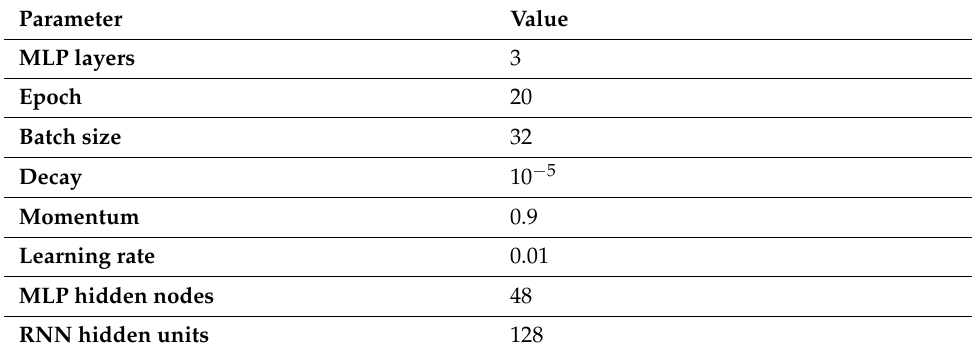
Table 3. Parameter configuration.